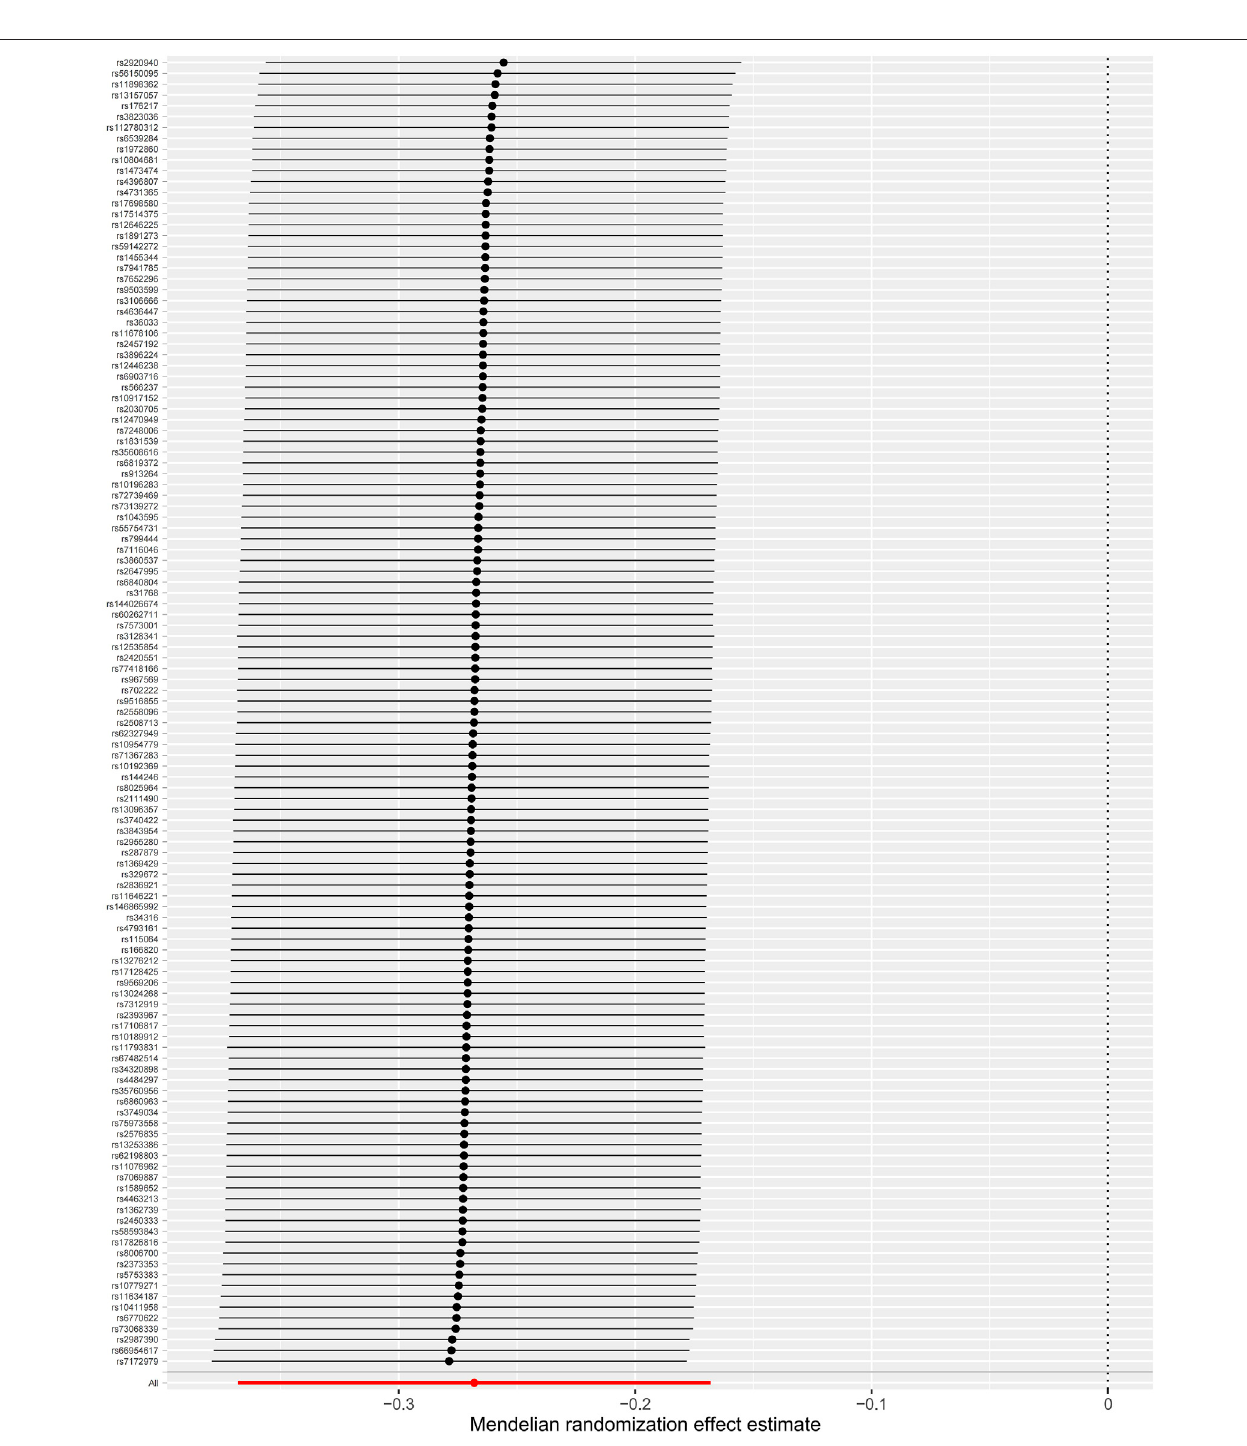
FIGURE 3 | Leave-one-out analyses of the associations between intelligence and coronary artery disease. The dots indicate the causal effect using the inverse- variance weighted method when the SNP is removed. The bars indicate a 95% con fi dence interval.